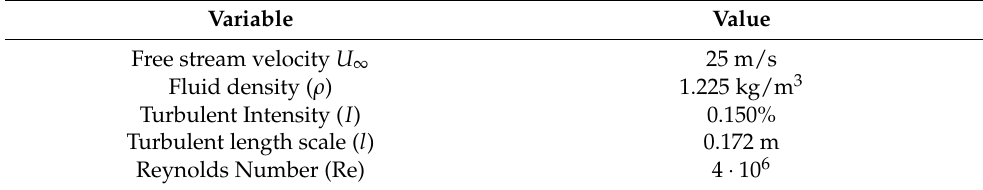
Table 2. Physical variables and initial conditions.